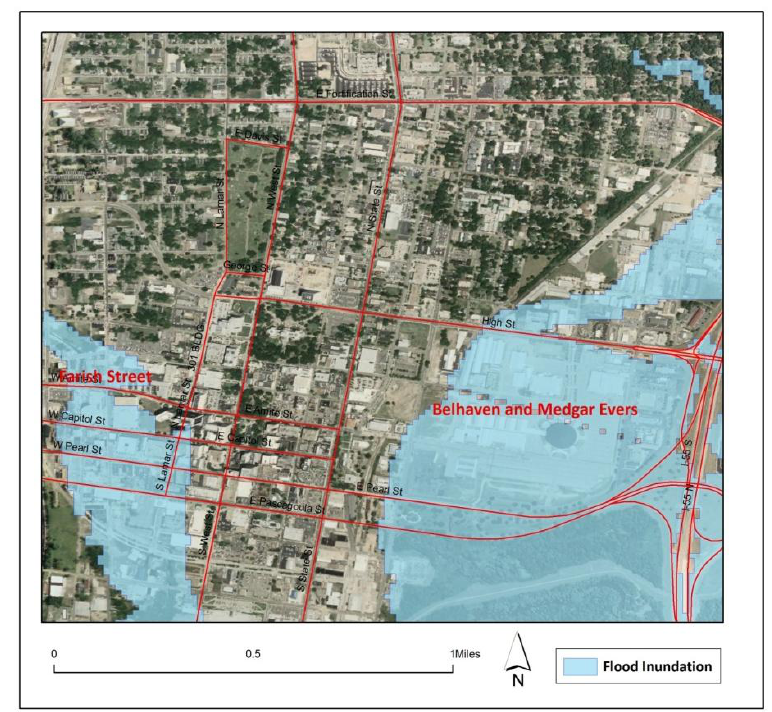
Figure 15. Inundation of the historic districts in downtown